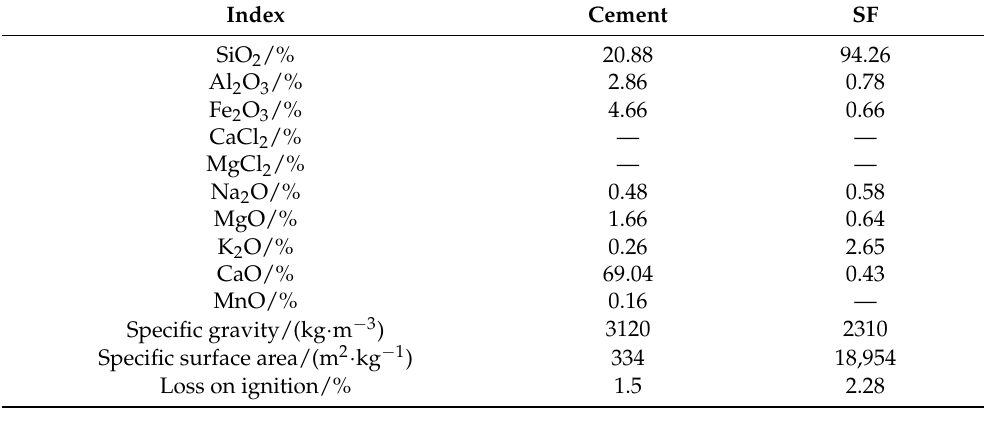
Table 2. Physical properties of aggregates.